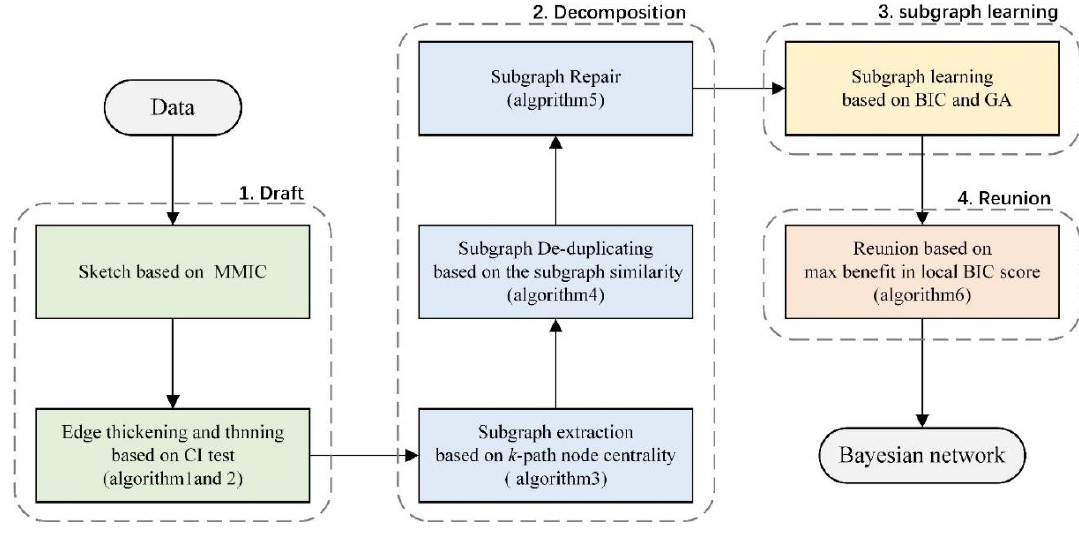
Figure 2. The flowchart of the proposed hybrid learning algorithm.